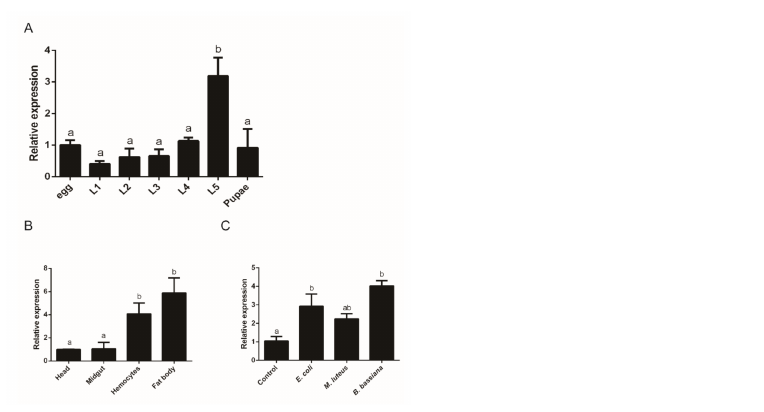
Figure 2. Expression profile analysis of O. furnacalis PGRP1 . ( A ) Expression profiles of O. furnacalis PGRP1 at different stages of development. RNA was extracted from the whole bodies of collected eggs; first-instar (L1), second-instar (L2), third-instar (L3), fourth-instar (L4), and fifth-instar (L5) larvae; and pupae. The rpL8 gene was used as an internal control. ( B ) Expression profiles of O. furnacalis PGRP1 in various tissues. Hd, head; Mg, midgut; Hc, hemocytes; Fb, fat body ( O. furnacalis ). ( C ) Expression profiles of O. furnacalis PGRP1 upon microbial challenge. On day 0, fifth-instar larvae were infected with PBS (Control), E. coli , M. luteus , or B. bassiana . RNA was prepared from the whole bodies 24 h after injection. The rpL8 gene was used as an internal standard to indicate a consistent total mRNA amount. Bars labeled with different letters are significantly different (one–way ANOVA, followed by Tukey’s multiple comparisons test, p < 0.05).